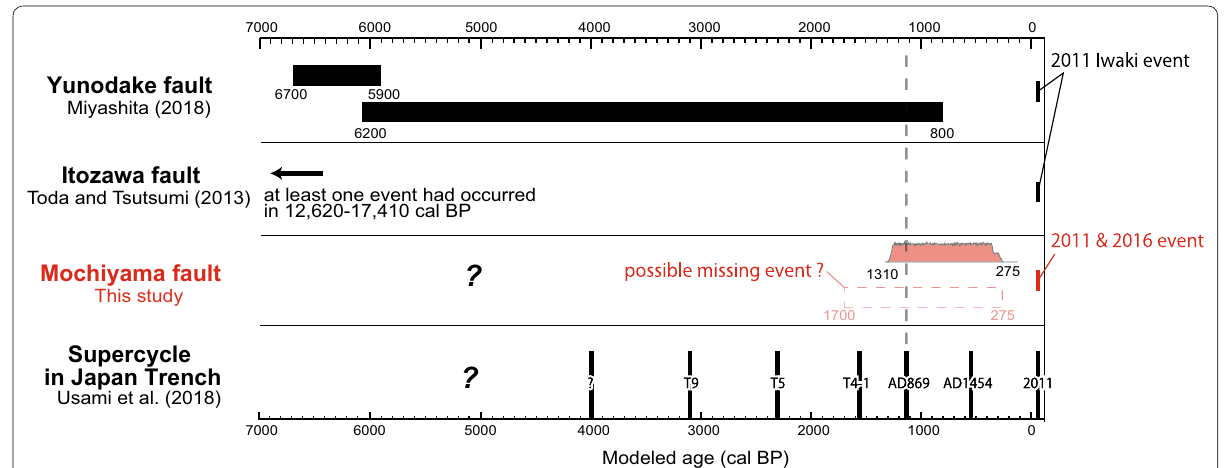
Fig. 10 Correlation of events on the Mochiyama fault and paleoearthquakes on the Yunodake and Itozawa faults. The bottom plot shows the timing of paleomegathrust earthquakes based on turbidite paleoseismology in the Japan Trench (Usami et al.